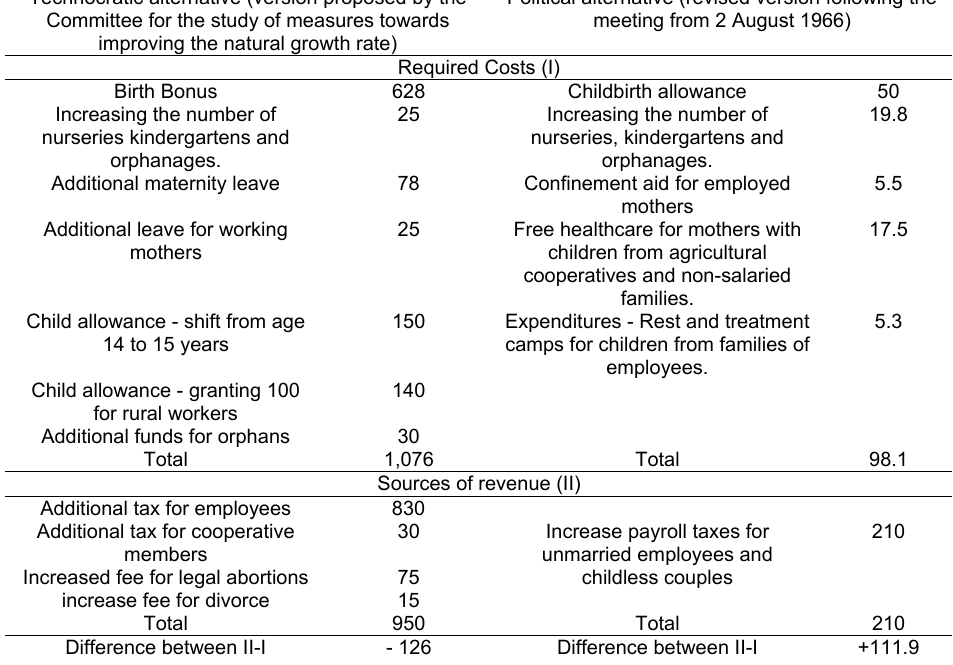
Table 1. Budgets of the two alternative pronatalist plans (in million Lei) Political alternative (revised version following the Technocratic alternative (version proposed by the meeting from 2 August 1966) Committee for the study of measures towards improving the natural growth rate) Required Costs (I) Birth Bonus 628 Childbirth allowance 50 Increasing the number of nurseries kindergartens and